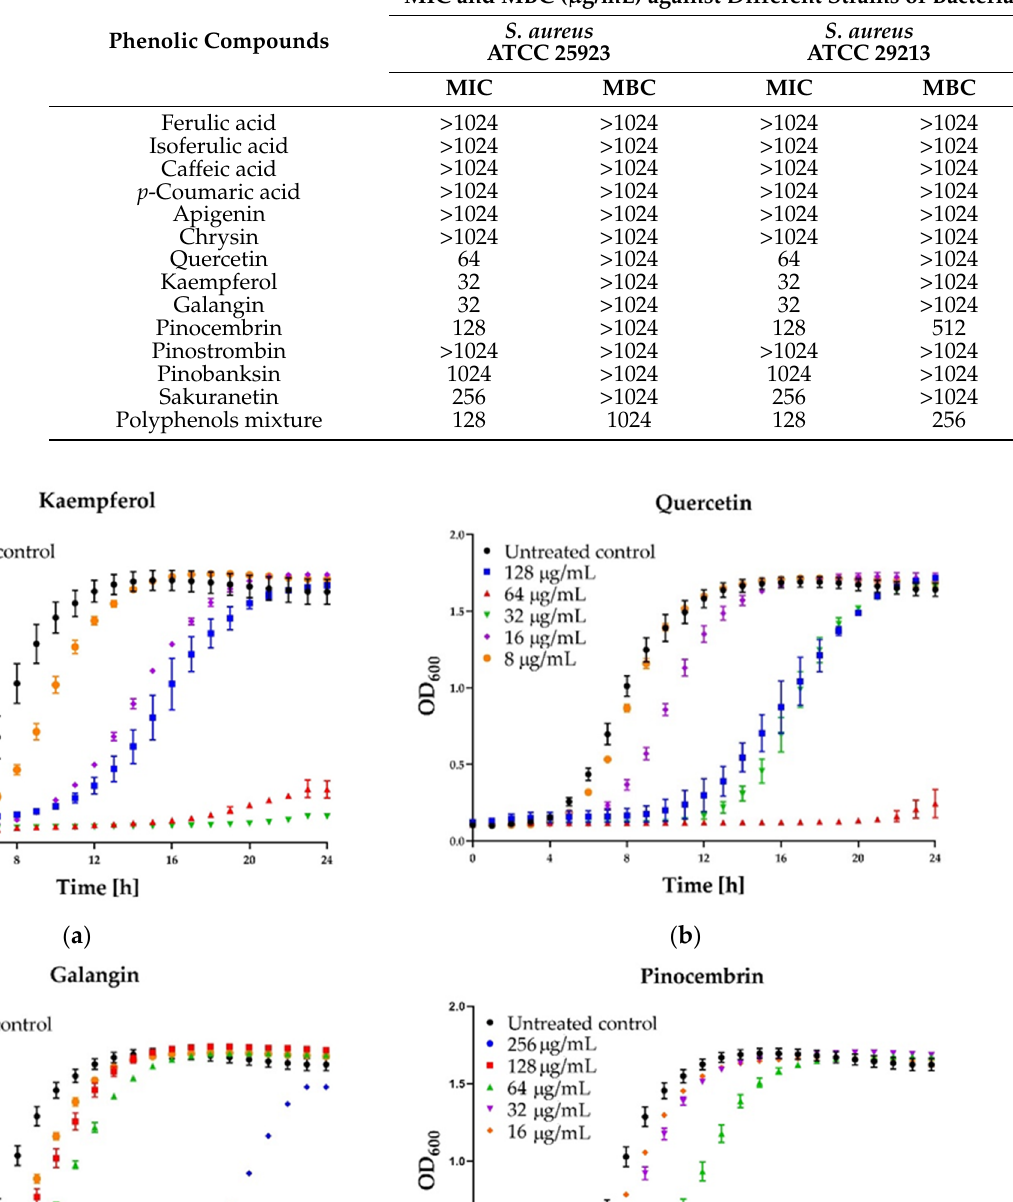
Table 5. Antimicrobial activity of propolis polyphenols and polyphenols mixture against reference strains of S. aureus.